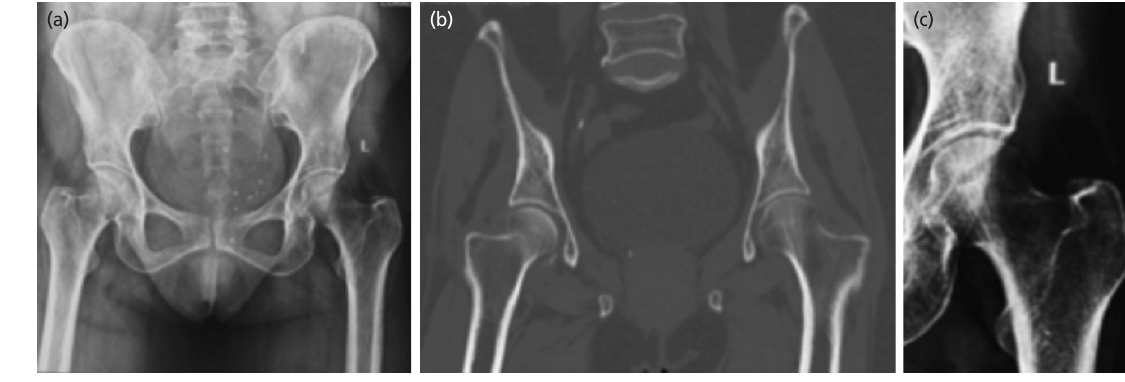
Case example, 80-year-old female, illustrating the trabecular pattern in proximal femur as evident on (a) pelvis radiograph (b) Fig. 2: mid coronal CT cuts (c) magnified normal left hip for better visualisation of trabeculae. Hip graded as Singh index 3 based on trabecular